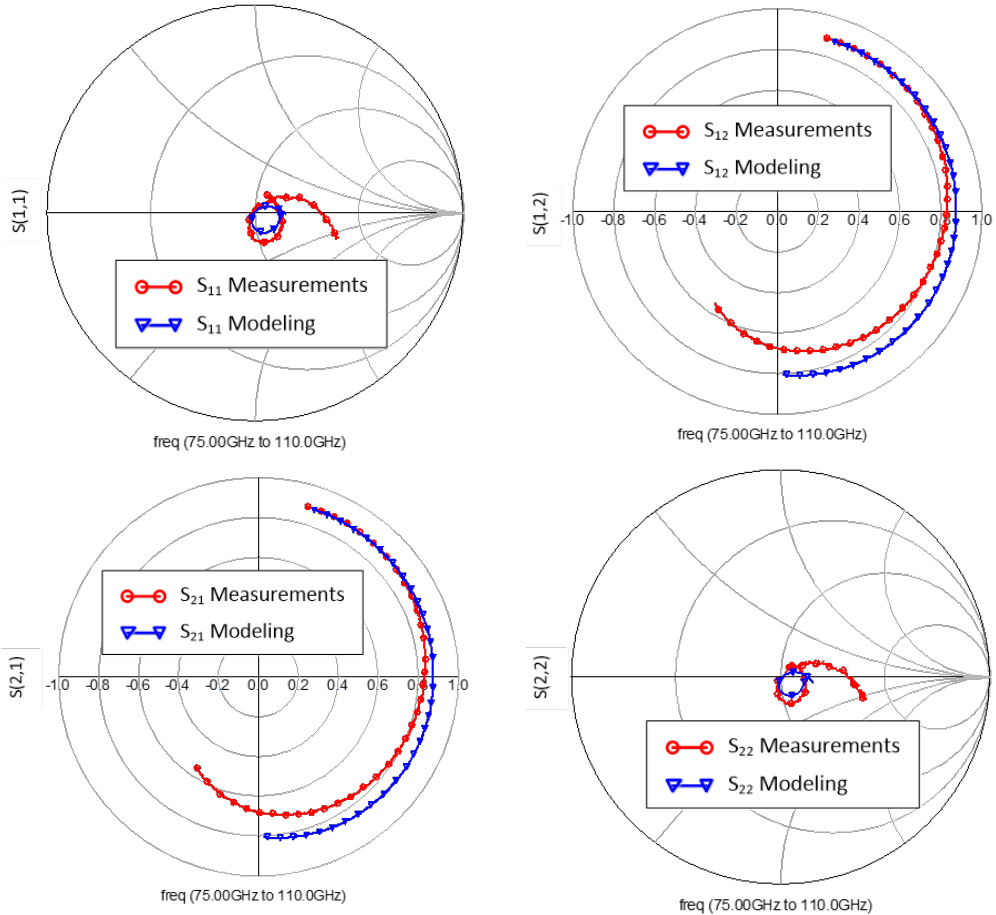
Figure 11. Comparison between S-parameter measurements and modeling simulation of the unbiased ZBD (0 V) for the flip-chip assembly in the W-band .